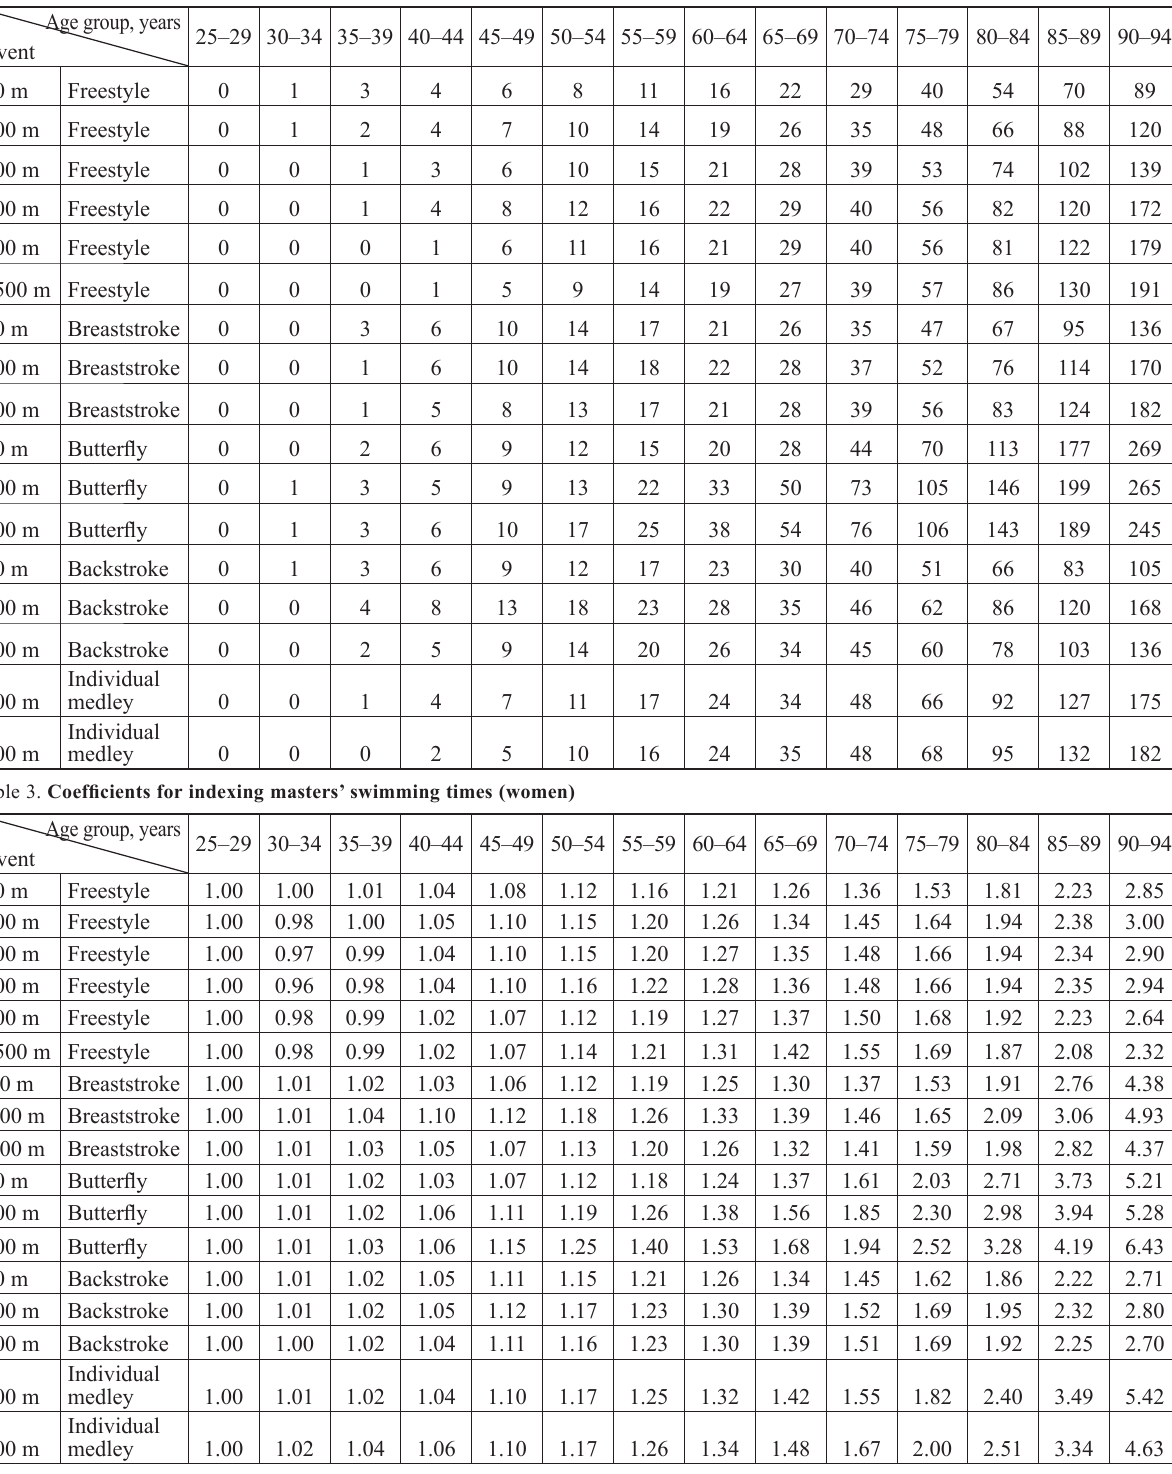
Table 2. Master swimmers’ (men) race time increase